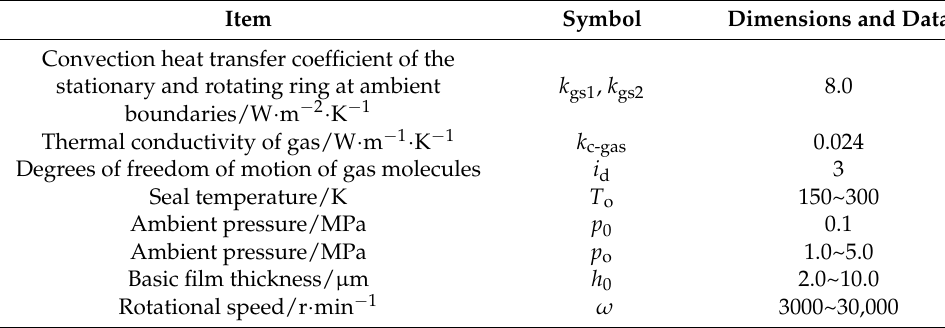
Table 2. Parameters of temperature